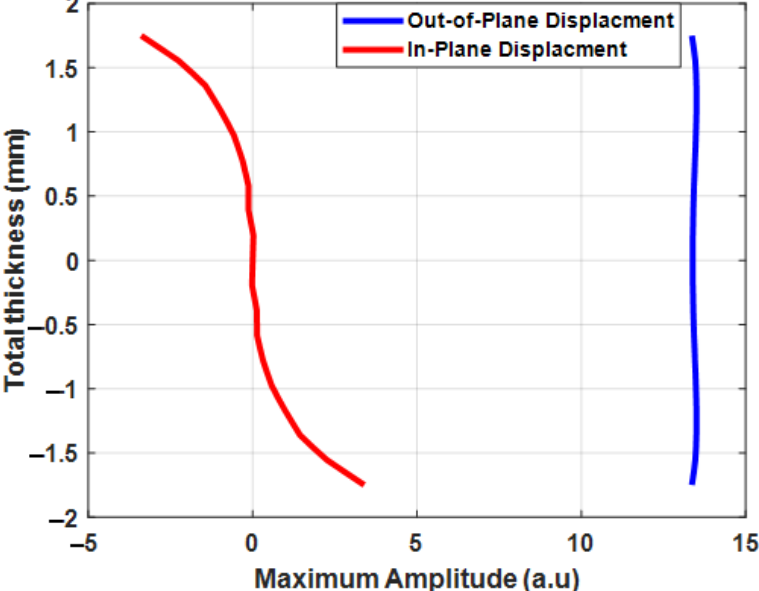
Figure 3. Through-thickness displacements and the maximum amplitude of the A (cid:2868) mode in the 3.5 mm-thick CFRP plate. 3.5 mm-thick CFRP